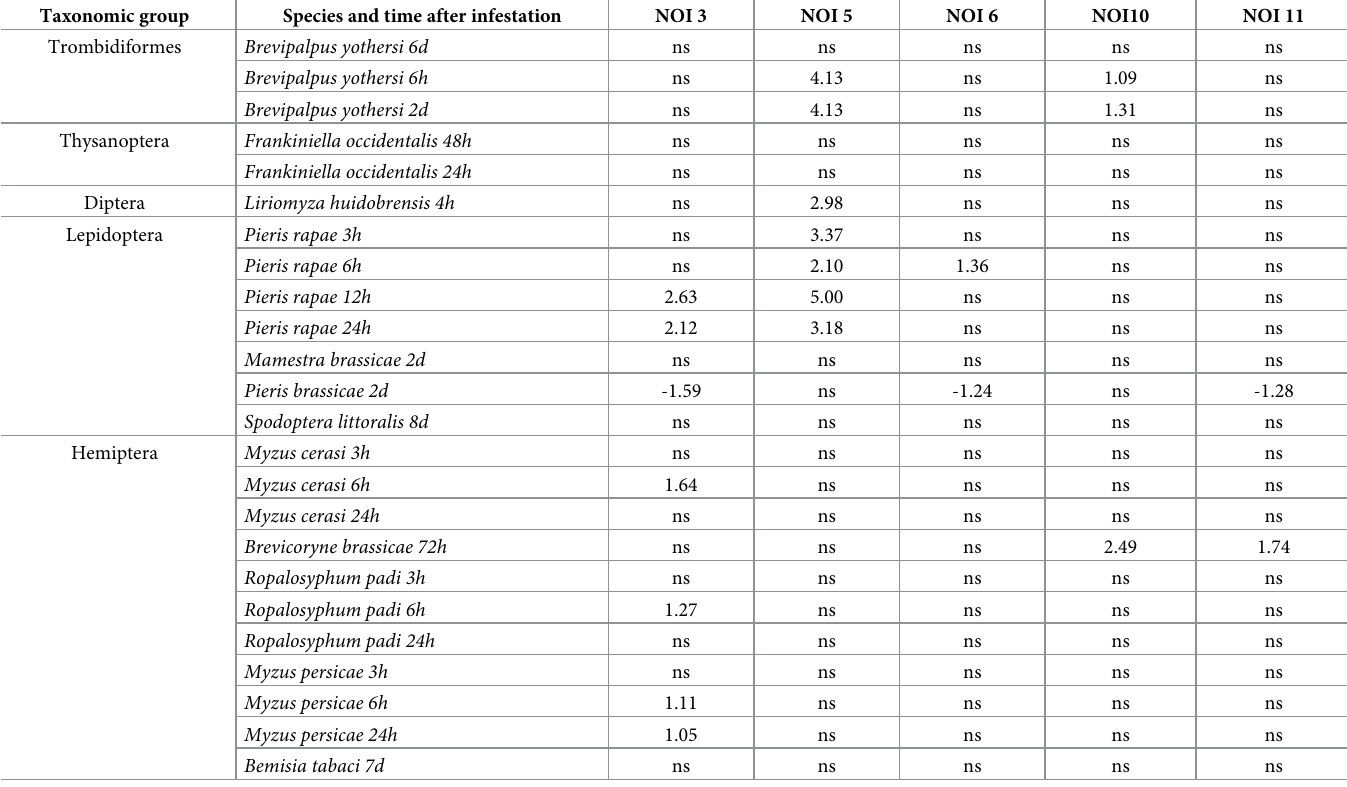
Table 2. Expression of NOI genes in A . thaliana infested with different arthropods. Taxonomic group Species and time after